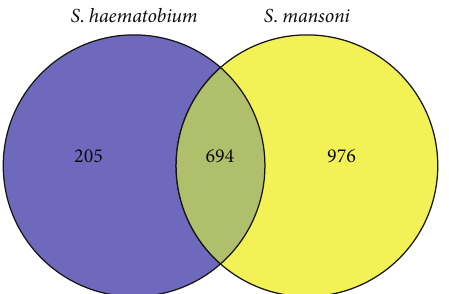
Figure 2: Venn diagram demonstrating shared and unique lncRNA